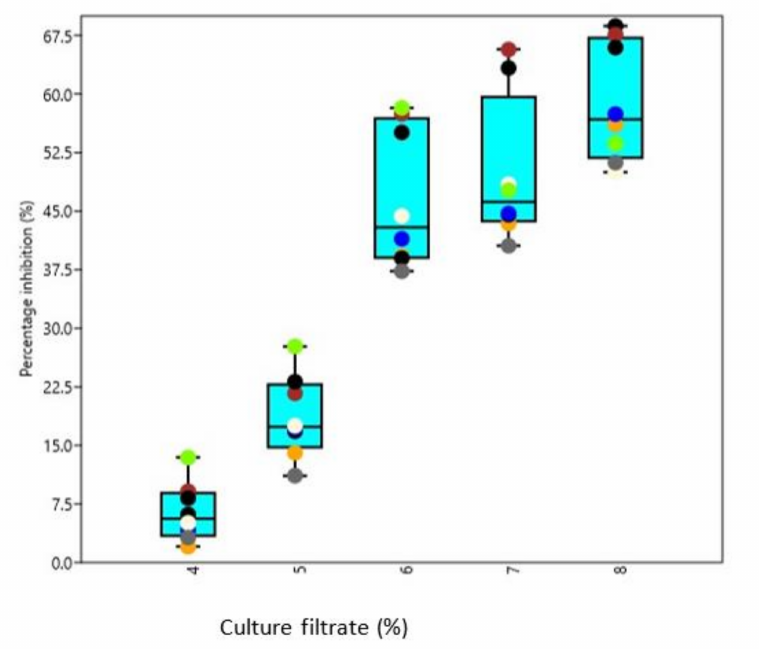
Figure 9. Box and Jitter plot representing percentage inhibition of P. aphanidermatum by various chitinase producing Trichoderma isolates. [Symbols in the plot represent: AT2: Orange; AT3: Black; AT7: Blue; BT1: Brown; BT3: Cornsilk; BT4: Chartreuse; BT7: Dim gray; BT8: